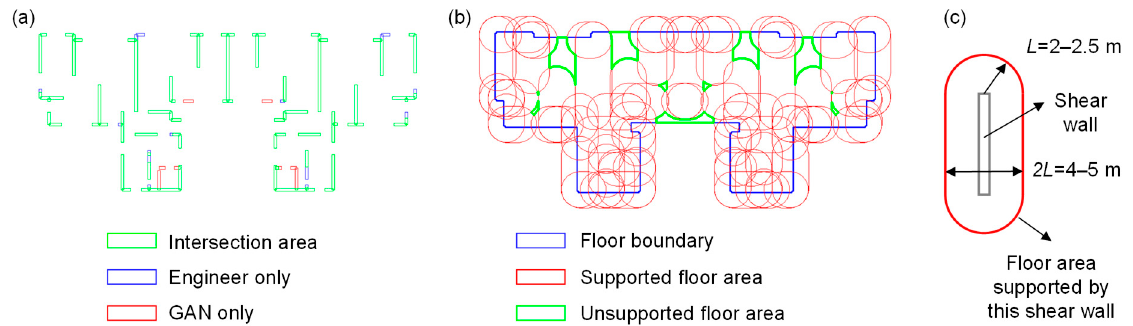
Figure 9. Evaluation method of shear wall layout: ( a ) planar layout consistency; ( b ) vertical load transferability; ( c ) floor area supported by a shear wall.